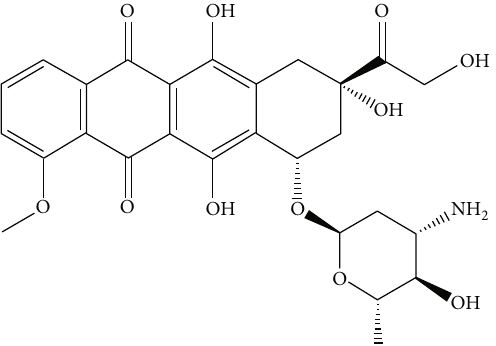
Figure 2: Related experiments based on doxorubicin-loaded targeting nanoparticles (TF-PEG-DSPE/DOX